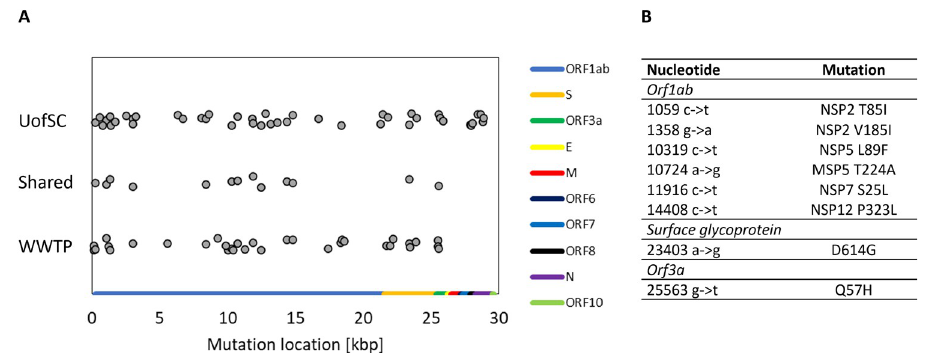
Fig 3. Mutational profiles of SARS-CoV-2 amplified from University of South Carolina (UofSC) building wastewater and Columbia metropolitan wastewater treatment plant (WWTP) influent. (A) Location of mutations detected in university wastewater samples and Columbia WWTP influent during September 2020. Dot Jitter was added for clarity to arbitrary y-axis values. (B) Substitutions identified in both university and Columbia WWTP influent. Only nonsynonymous mutations located in coding regions are shown in the table.